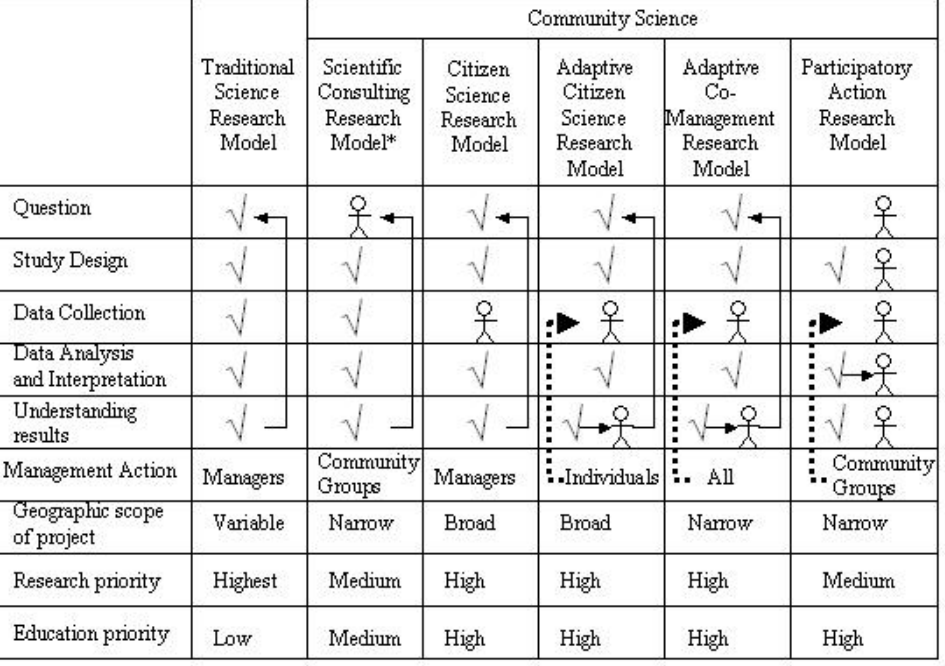
Fig. 1. Different ways that scientific inquiry can inform the adaptive management of natural resources, with the scale of management, as well as optimizing the dual goals of research and education, maximized in the Citizen Science and Adaptive Citizen Science models. Check marks indicate professionals; stick people represent public participants. Dashed arrows indicate the iterative aspect of the adaptive management process and solid arrows indicate the iterative aspect of the scientific process. Small arrows between professionals and public participants indicate points of intensive transfer of information, an important element to ensure “buy-in” of participants in taking action. The degree of collaboration between professionals and non-professionals increases from left to right. Expanding the Citizen Science Research model to Adaptive Citizen Science Research model as described in this paper integrates more levels of public participation without sacrificing scale, such that management can be coordinated and evaluated